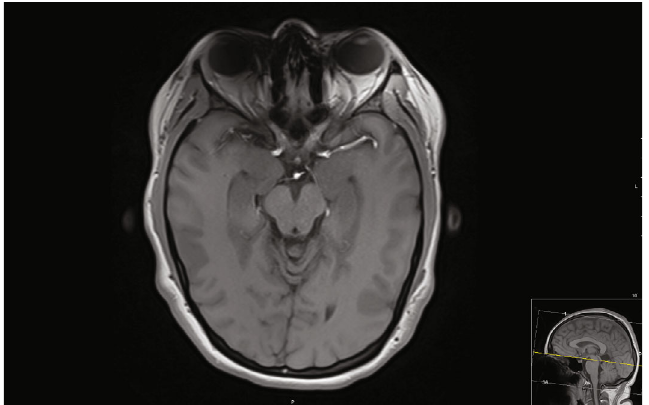
Figure 1: T1 sequence of axial view of brain. No cortical ischemia or hemorrhage was visualized. No evidence of compression or injury to optic